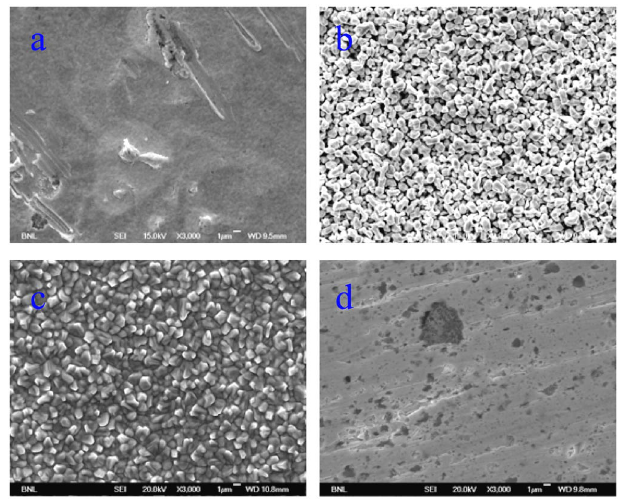
FIG. 8. (Color) Schematic of experimental arrangement, show- ing: (A) monochromator, (B) lens, (C) anode grid, (D) cathode, and (E) location of power meter.